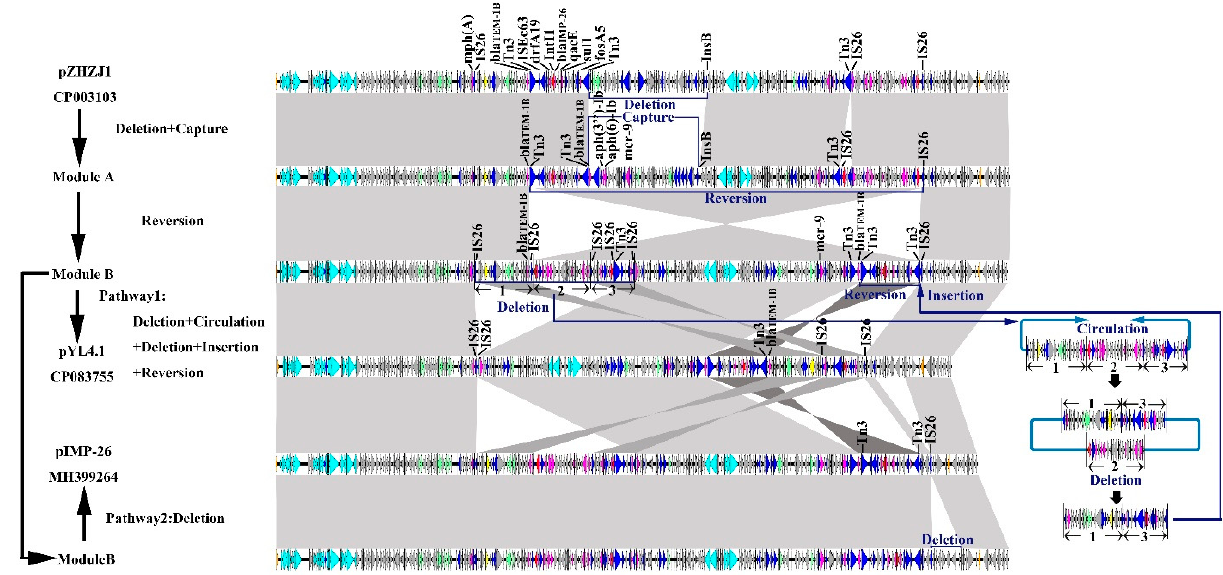
Figure 4. Evolutionary path between pEHZJ1 (CP033103), pYL4 (CP083755), and pIMP-26 (MH399264). The arrows indicate ORFs that have been confirmed or putatively confirmed and their orientations. Length of the arrow corresponds to the predicted ORF. The color code represents: replication initiation protein genes (orange), integrase genes (red), transposase genes and insertion elements (blue), antibiotic resistance genes (magenta), toxin-antitoxin system genes (yellow), heavy metal resistance genes (green), conjugal transfer genes (cray), putative, hypothetical, and other genes are represented by gray arrows. Shaded gray areas denote homologous regions with up to 95% nucleotide identity. When the shadow areas overlap, the color of the shaded region is darkened.